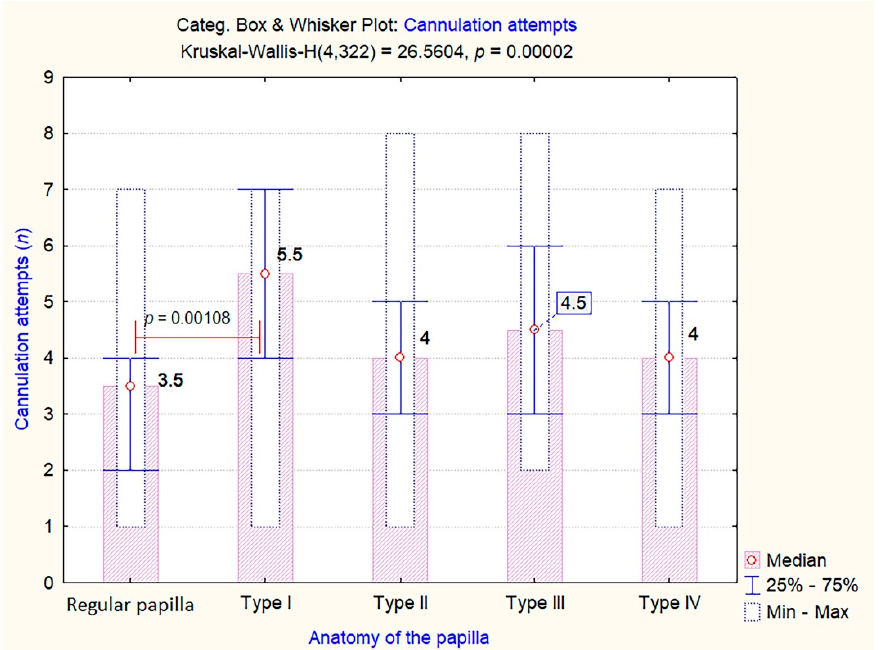
Figure 4. Number of cannulation attempts among the different endoscopic aspects of the papilla. Levene Test of Homogeneity of Variances: F = 1.3557, p = 0.249188. Levene Test of Homogeneity of Variances: F = 1.3557, p =